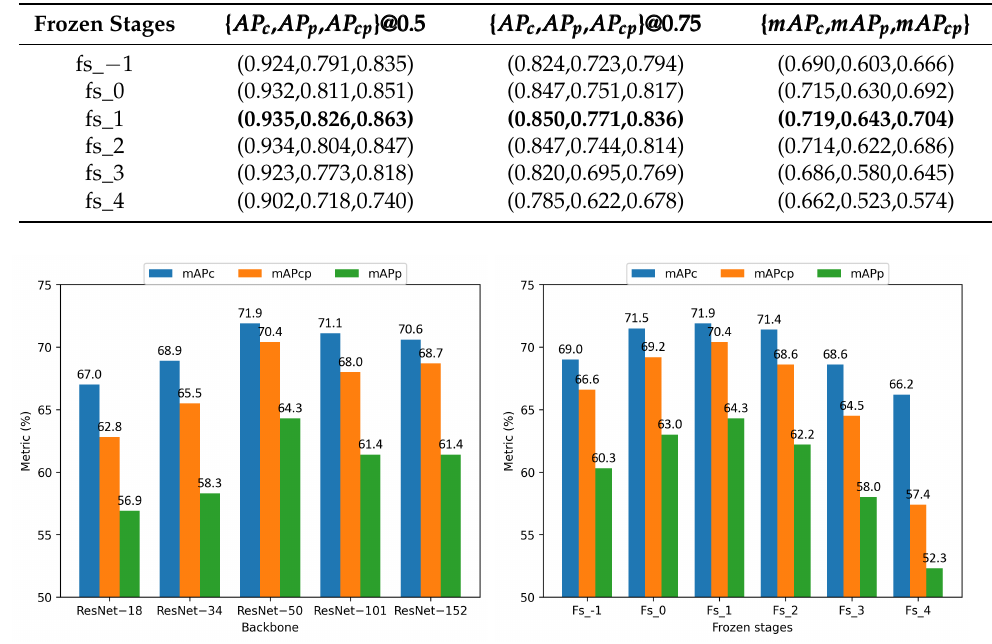
Figure 9. Illustration via bar chart of the effect of the backbone network ( left ) and frozen_stages ( right ) on the mAP metric on the IPHPDT